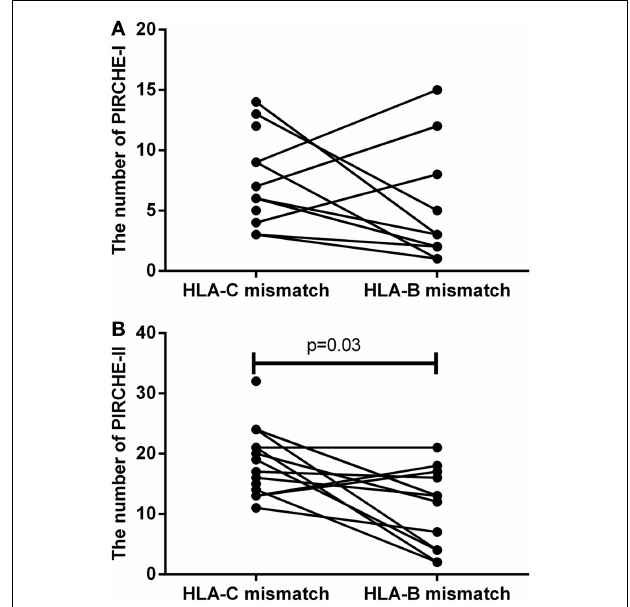
FIGURE 4 | (A) The number of PIRCHE-I for the selected HLA-C mismatch, compared to a potential HLA-B mismatch. (B) The number of PIRCHE-II for the selected HLA-C mismatch, compared to a potential HLA-B mismatch. For 17 patients with high numbers of mismatched HLA-C-derived PIRCHE-I and -II, we analyzed whether we could potentially find a mismatched HLA-B alternative donor.We found that in 7 (54%) of these cases, we could reduce the number of PIRCHE-I with this strategy and in 9 (69%) of these cases we could reduce the number of PIRCHE-II.The numbers of PIRCHE-II are significantly lower when we would have chosen the potential HLA-B mismatch instead of the selected HLA-C mismatch (Wilcoxon matched-pairs signed ranked test, p =